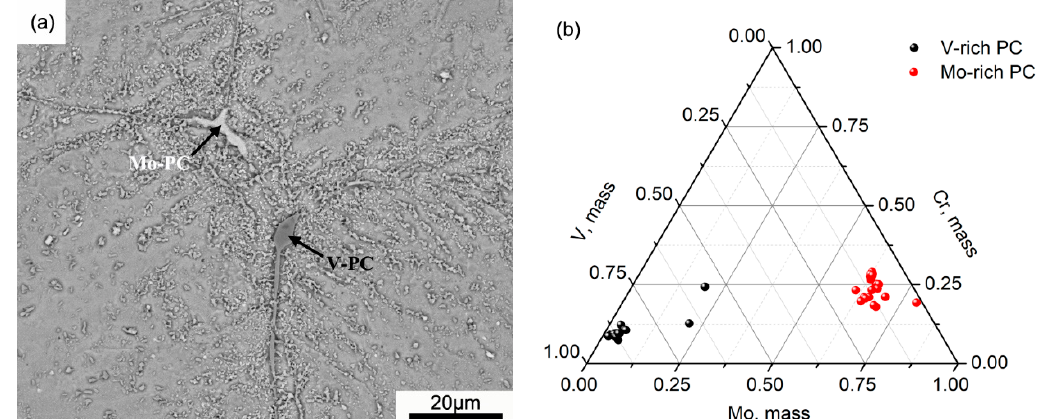
Figure 3. Typical primary carbides in H13 ESR ingot: ( a ) morphology of V-rich primary carbide (V-PC) and Mo-rich primary carbide (Mo-PC), and ( b ) composition distribution of V-rich PC and Mo-rich PC (online version in color).